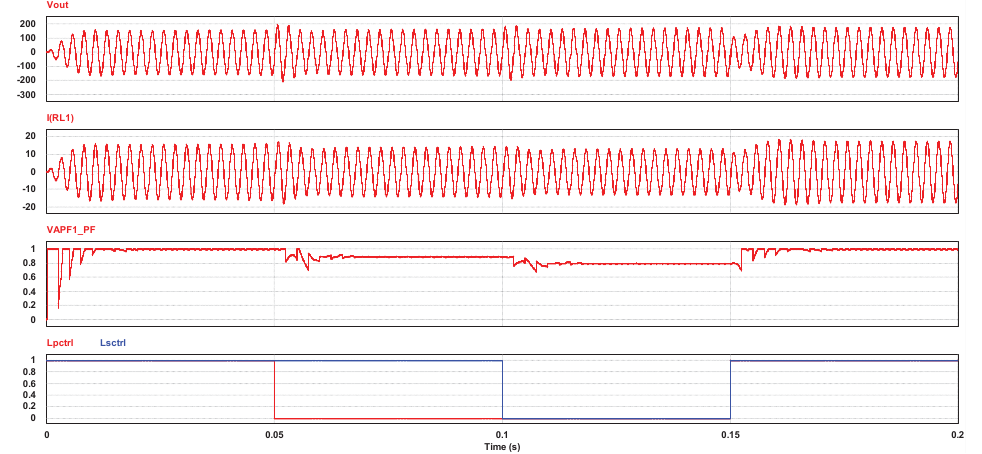
Figure 12. Simulation results for 2 mH and 3 mH load cases.